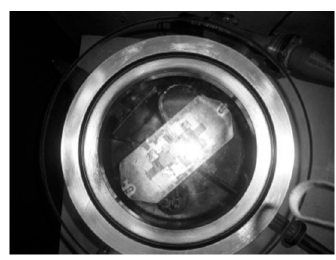
Figure 4. The aluminum metallization process as the film’s contact medium.